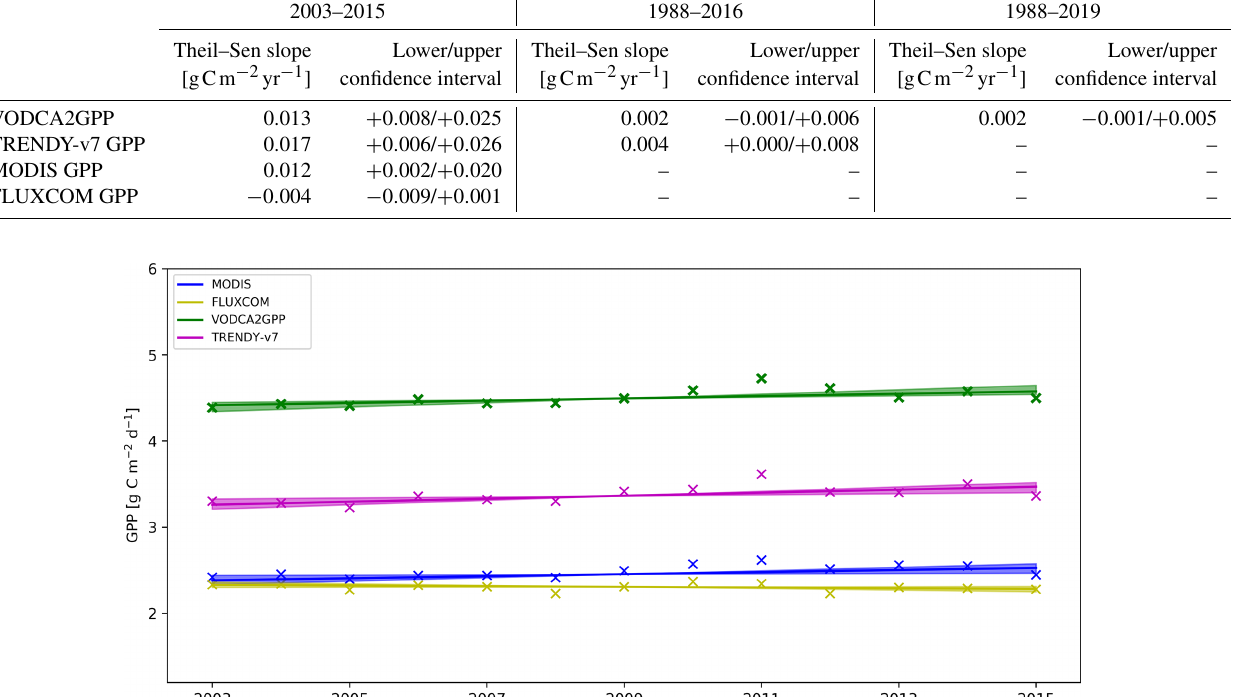
Table 3. Theil–Sen trends in global yearly median GPP. Same signs of the upper and lower 90% confidence interval indicate significant trends. The analysed periods are 2003–2015, which corresponds to the fully overlapping periods for all datasets (for the period 2002–2016 there were some data gaps in the MODIS and FLUXCOM data used at the very beginning/very end; since these data gaps could potentially impact the slope estimation, the slightly shorter period 2003–2015 was used); 1988–2016, which corresponds to the fully overlapping period of VODCA2GPP and TRENDY-v7; and 1988–2019, which corresponds to all available complete years of VODCA2GPP data.